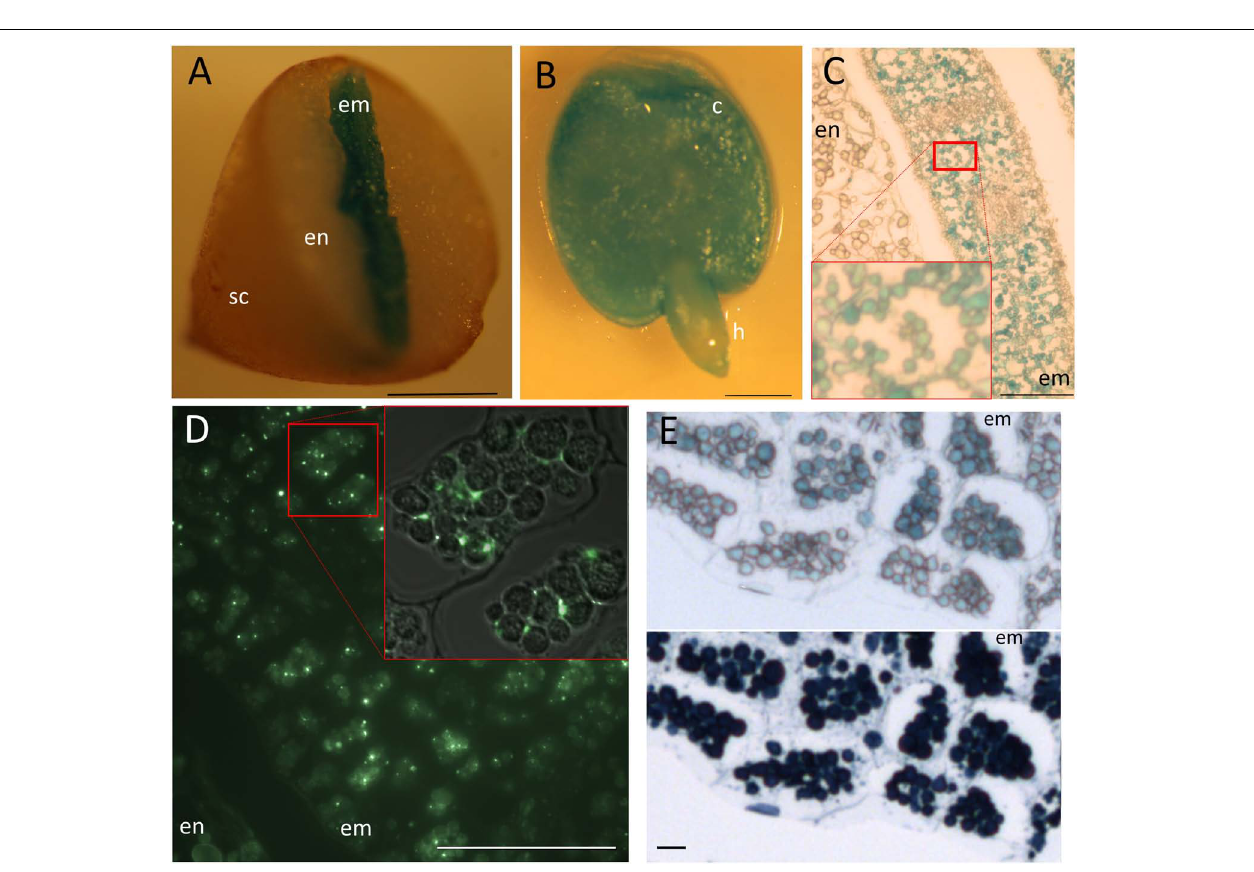
FIGURE 5 | Fe storage in Carica papaya . Distribution of Fe as subcellular hotspots in Carica papaya seeds. Carica papaya seeds were cleaned from the pericarp. (A) Seeds were cut into half by hand and were stained by Perls. (B) Whole embryo was isolated from the seed and was stained by perls. (C) Perls-stained thin cross section of a cotyledon. Red squares indicate close up. (D) Immunohistochemistry using ferritin antibodies. Bright green spots indicate ferritin presence. Red square indicates closeup, fluorescence image overlayed on top of the light microscopy image to indicate localization of fluorescent spots with regards to the Fe storing organelles. (E) Juxtaposition of Fe-stained and protein-stained regions of the embryo cross sections. The same cross section was first stained by Perls, pictured (top panel) and then stained by Naphthol Blue–Black, pictured again (bottom panel). Blue color in panel (A–C) and in the top panel of (E) indicate stained Fe. Note, the cellular position and number of the organelles slightly differ in panel (C) , compared with (D) and (E) . The difference might be due to a fixation artifact or cross sectioning from distinct regions of the embryos. Dark blue color in the bottom panel of (E) indicates presence of proteins. sc, seed coat; en, endosperm; c, cotyledon; h, hypocotyl; em, embryo. Bar is 1 mm for panels (A,B) ; 0.05 mm for panel (D) ; 0.1 mm for panel (C) ; 0.01 mm for panel (E)